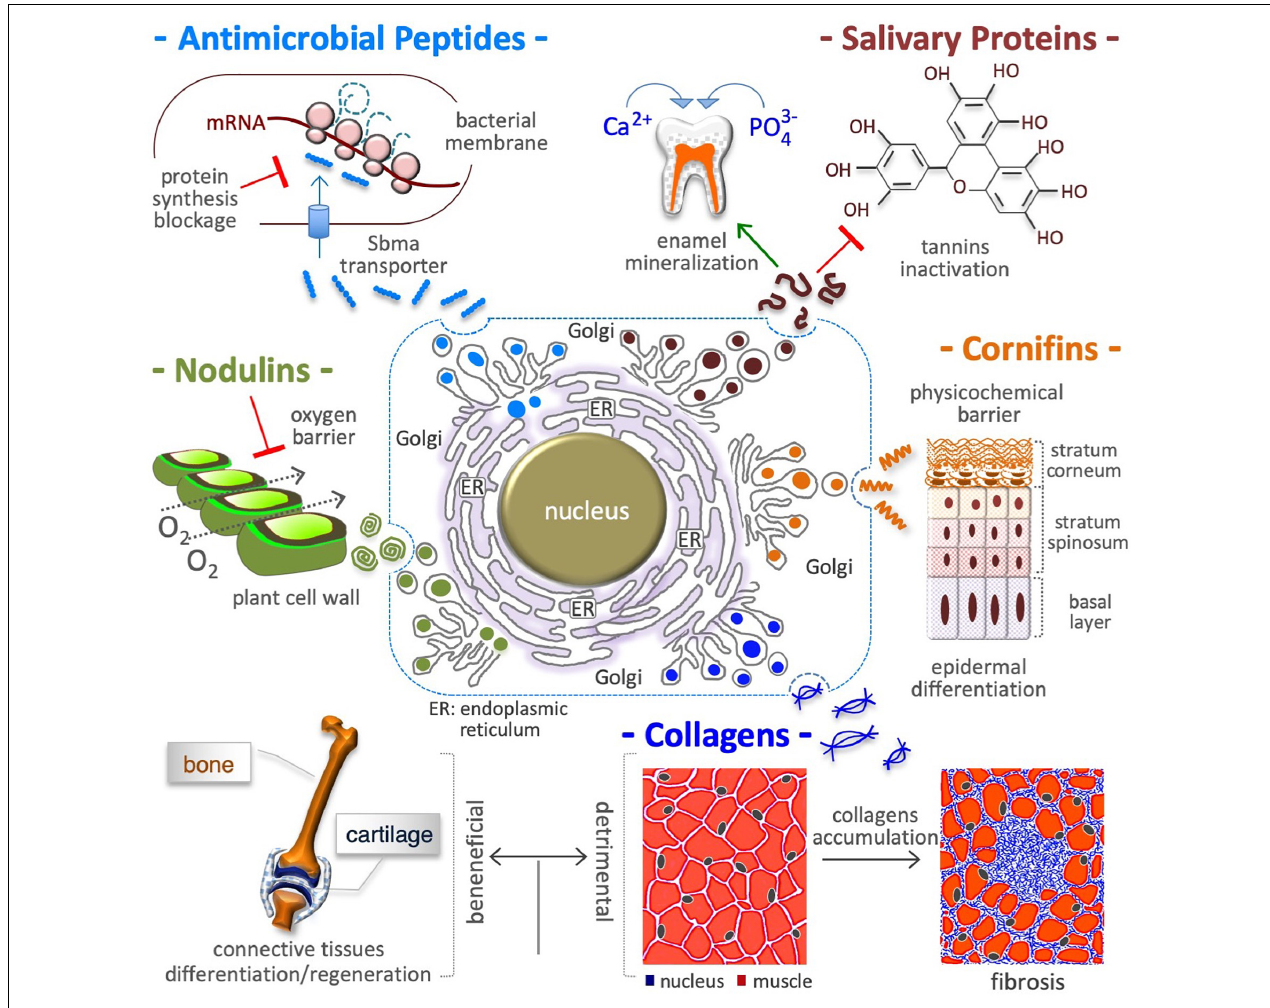
FIGURE 2 | Proline in extracellular matrix production. Proline is a crucial building block of antimicrobial peptides, salivary proteins, epidermal cornifins, interstitial collagens, and plant nodulins. These proteins are all rich in proline residues (with up to 50% of total amino acids) and are all secreted in the extracellular space. In addition to shape cell/tissue microenvironment/architecture (fibrillar collagens), proline-rich proteins contribute to innate immunity (antibiotic activity) by inhibiting bacterial protein synthesis ( top left ) , to diet selection (astringency) by binding polyphenolic tannis ( top right ) and, to teeth health by inducing enamel mineralization and preventing bacterial attacks ( top right ) , to selective permeation (barrier of water, O 2 ) by nodulins in N 2 fixing root nodules of leguminous plants ( middle left ) , and by cornifins in skin ( middle right ) , and to signaling mechanical forces (ECM stiffness). The accumulation of interstitial collagens leads to pathological fibrosis and occurs in different tumoral tissues ( bottom right )